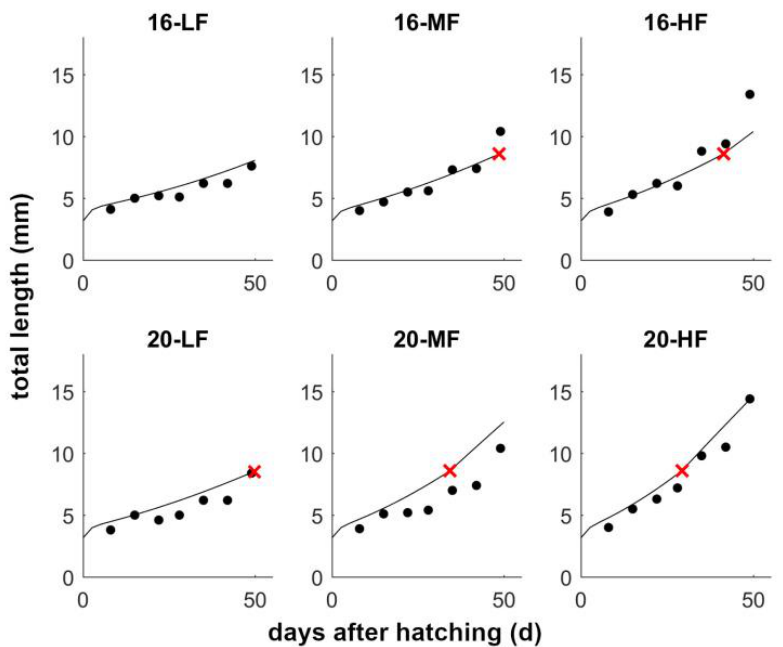
Figure 1. Model validation for S. solea . Larvae length (points) and DEB model larval growth predictions (lines) for S. solea larvae reared at three food availabilities (HighFood, HF; MediumFood, MF and LowFood, LF) and two constant temperatures (16 °C and 20 °C). Red X in the panels (where present) marks the end of metamorphosis as predicted by the model. Experimental conditions were modeled as follows: temperature for incubation 13 °C, hatching to birth: 16 °C, after birth: 16 °C (top row) or 20 °C (lower row). Temperature switches in the simulations are linked to life stage (maturity), not time. Size at birth will depend on the scaled food availability ( f ) experienced by the mother ( f = 0.5), while subsequent growth will depend on experimental conditions (food and temperature) experienced by the larvae. Experimental f for larvae corresponds to feeding regimes: f LF = 0.1, f MF = 0.15, f HF = 0.18. All f values were adjusted manually. Physiological parameters were kept fixed at values listed in Table 2.